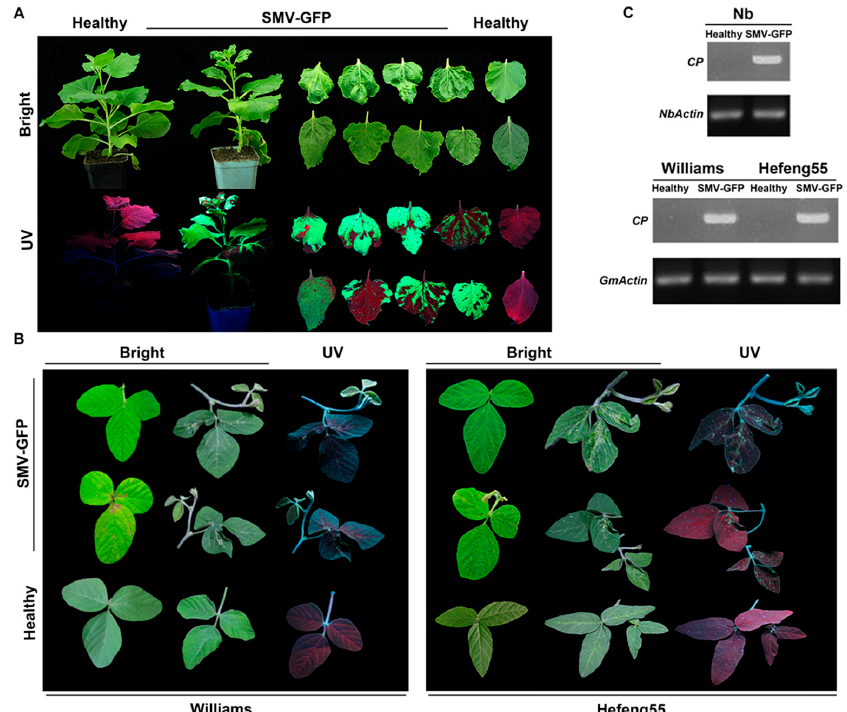
Figure 2. Infectivity of SMV-GFP infectious clone in N. benthamiana and of SMV-GFP in soybeans. ( A ) Symptoms of SMV-GFP-infected N. benthamiana plants and representative leaves. Bright, natural light. UV, 352 nm. ( B ) Symptoms of SMV-GFP infected soybean plants and representative leaves. ( C ) RT-PCR analysis of SMV via coat protein (CP) region-specific primers in N. benthamiana and soybean leaves at 12 dpi. The internal reference gene actin was used as a control.